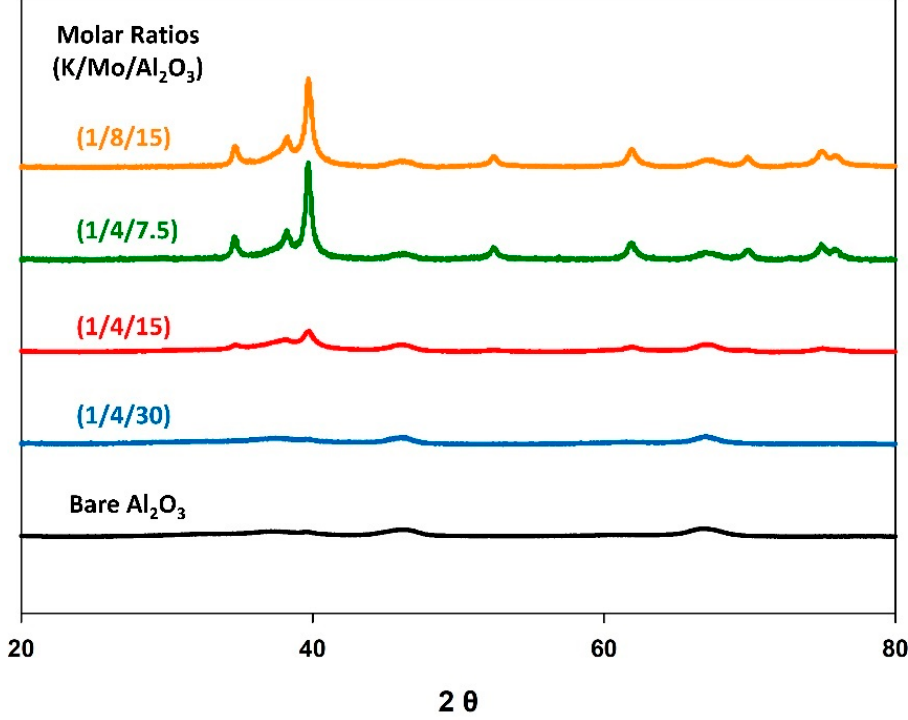
Figure 3. Normalized X-ray diffraction patterns for the K-Mo 2 C@ γ -Al 2 O 3 of various precursor load- ings.